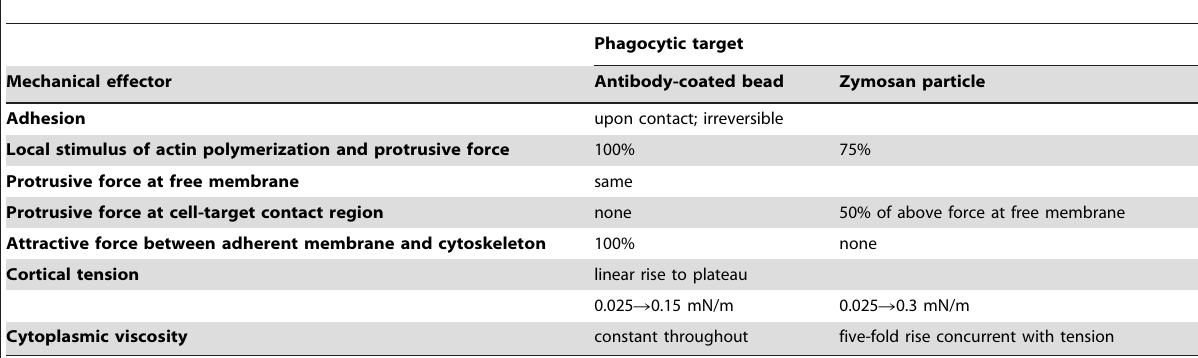
Table 1. Summary of mechanoeffectors in the target-specific computer models.